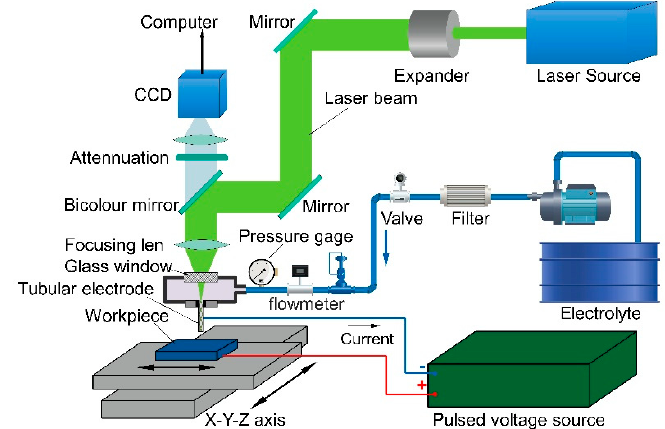
Figure 3. Experimental setup for Laser-STEM.